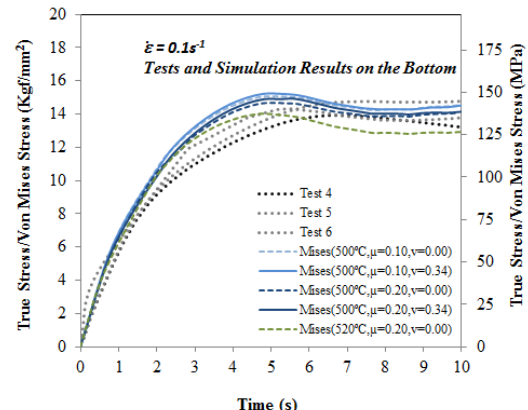
Figure 13. True stress vs. True Strain curves measured experimentally (dotted lines), and Von Mises Stress vs. Von Mises Equivalent Strain curves on the bottom of the sample calculated from simulations (solid and dash lines), all of them for tests at 540 °C and strain rate of 0.1s -1